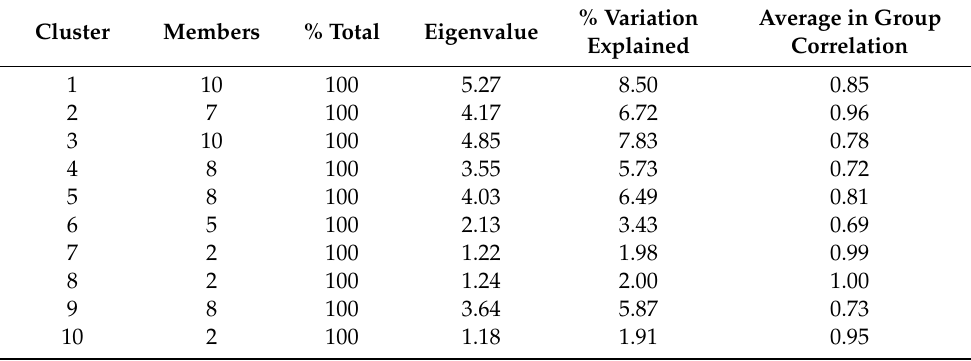
Table A3. Universality, strength, and consistency at the landscape